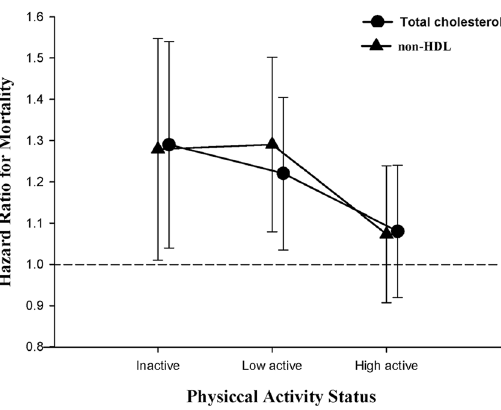
Figure 3. Mortality risks by physical activity status among individuals in the highest quintile of total cholesterol or non-high-density lipoprotein